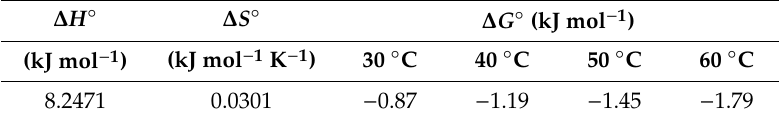
Table 2. Thermodynamic parameters for the adsorption of RR120 on the